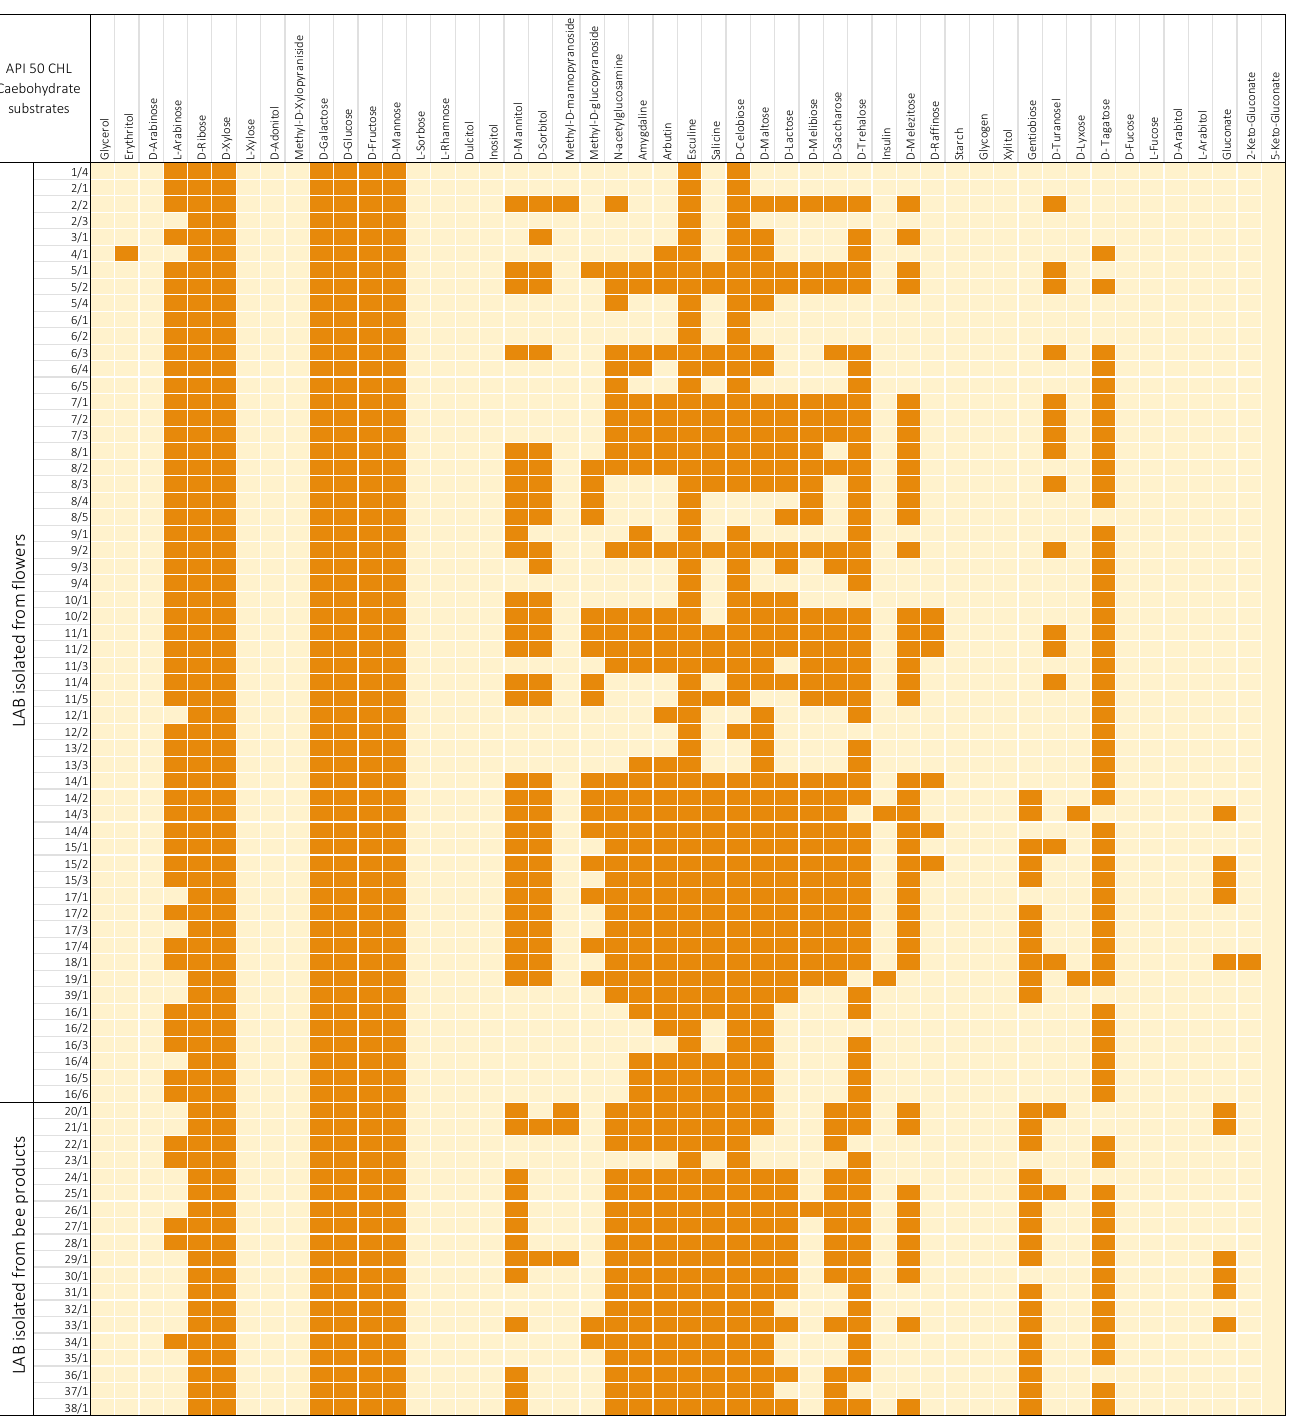
Figure 2. Utilization of sugars by isolated strains of lactic acid bacteria. The darker color indicates a positive test result, and a lighter one—a negative result.